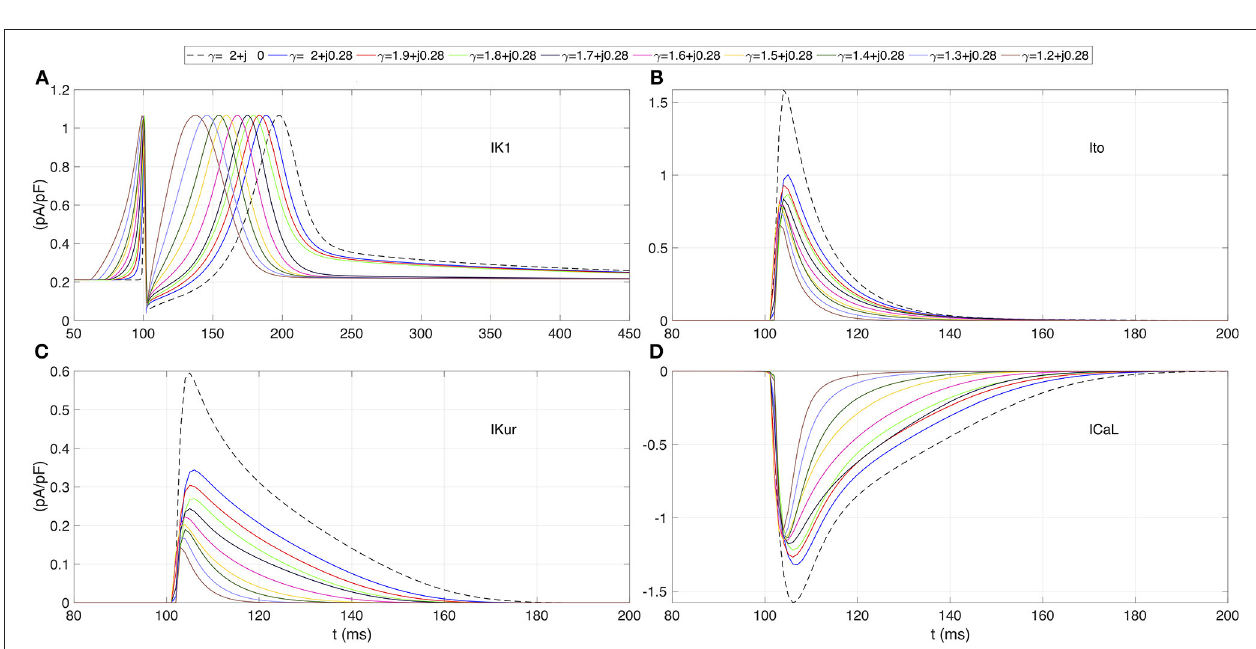
FIGURE 2 | Transmembrane ionic currents registered at the center of the atrial strand for several test values of γ . (A) Rectifier potassium current IK 1. (B) Outward transient potassium current Ito . (C) Ultrarapid delayed rectifier potassium current IKur . (D) L-type calcium current ICaL . Dashed line corresponds to standard diffusion and colored curves correspond to test values of γ